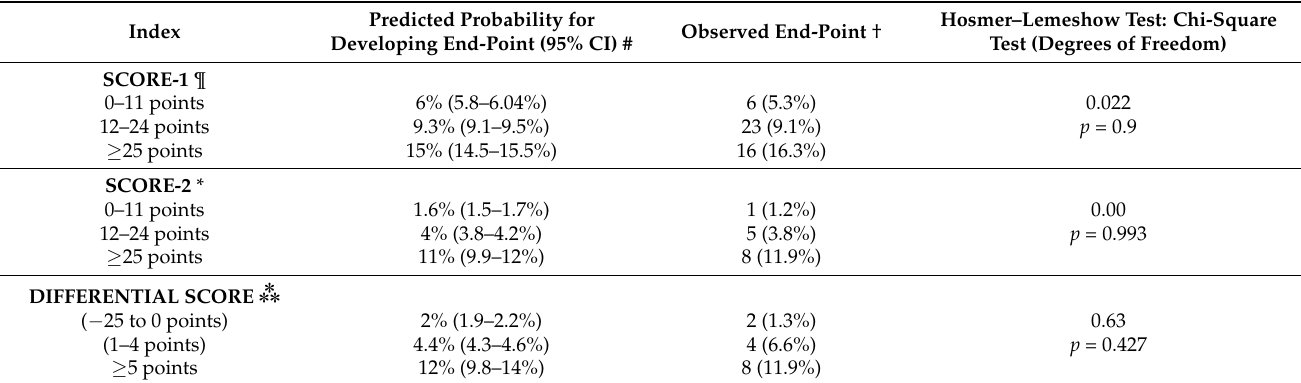
Table 2. Calibration of two point-of-care ultrasonographic scores by comparison of their risk strata classification predictions, and observed endpoint (orotracheal intubation or death) in a multicenter cohort of in-hospital patients with COVID-19 in Spain.